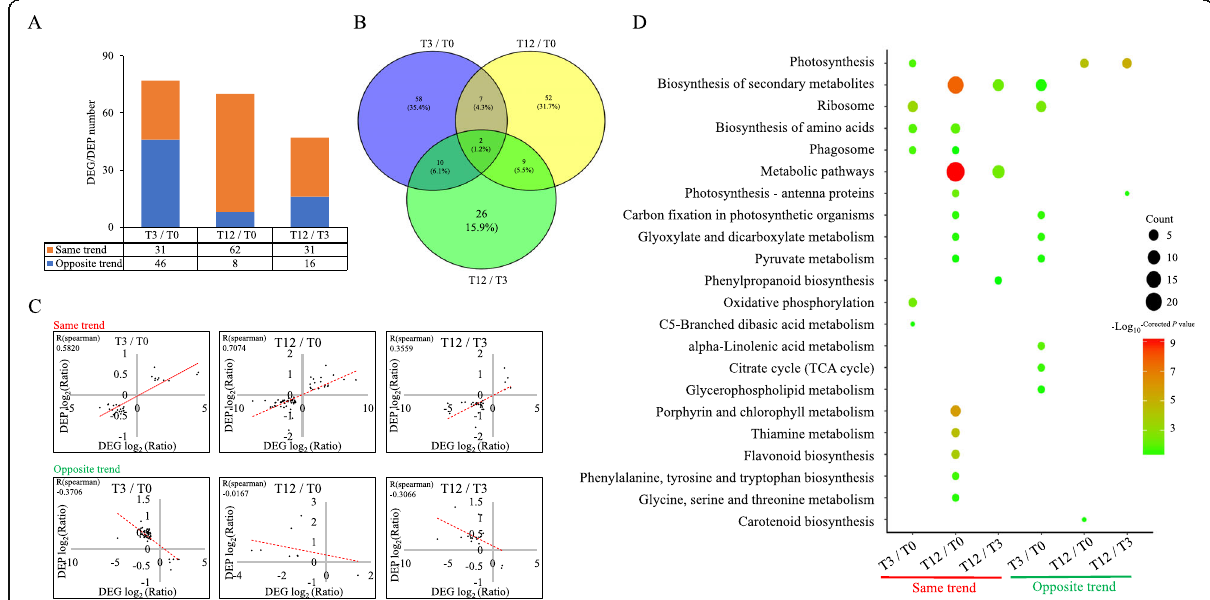
Fig. 2 Statistics and functional analysis on the correlation between DEGs and DEPs. a Statistics on the number of correlated DEGs and DEPs. b Venn diagram of correlated DEGs/DEPs. c Concordance between the gene changes at transcriptome and proteome levels. d Functional enrichment analysis of the correlated DEGs and